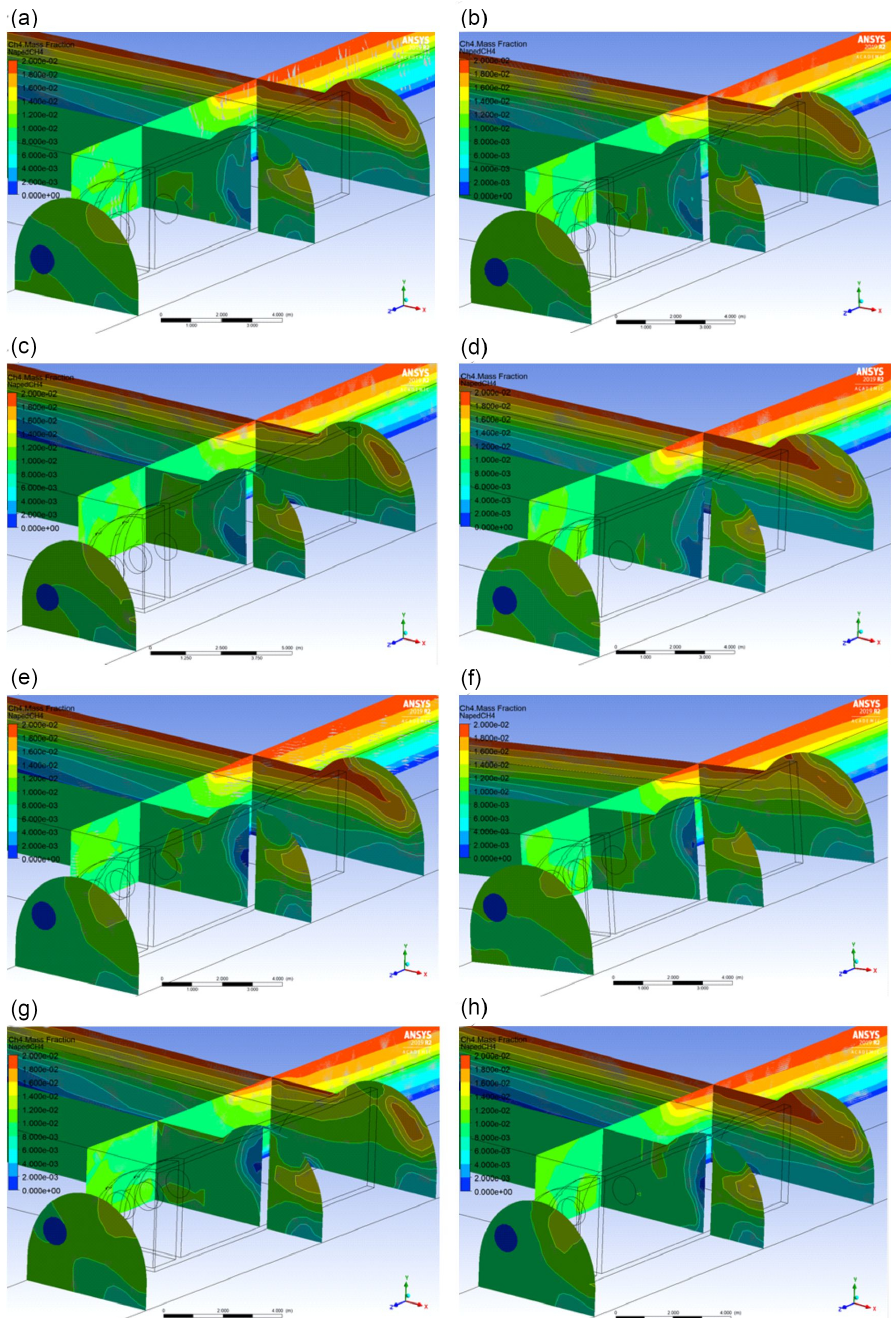
Figure 7. Distribution of methane concentration at result planes in the actual sensor